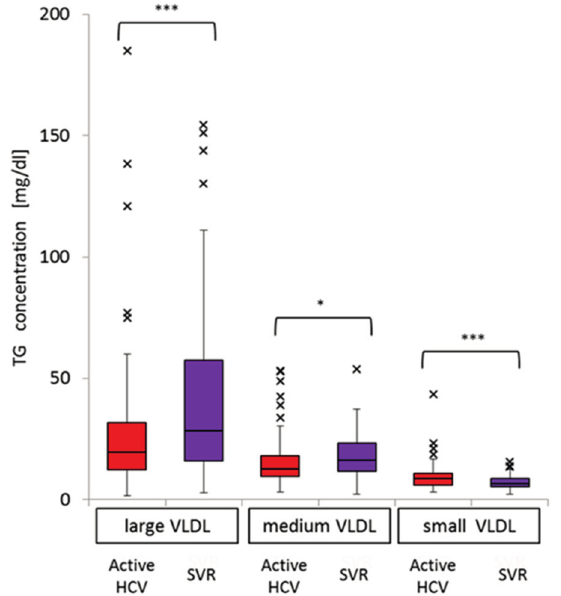
Figure 3. Comparison of the distribution of TG levels in the three VLDL sub-fractions for